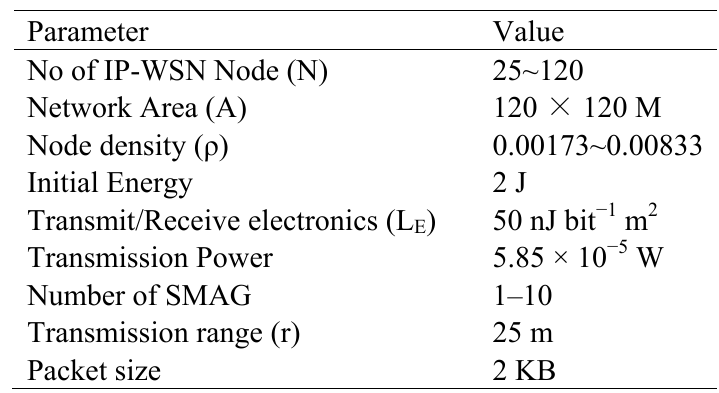
Table 2. Parameter